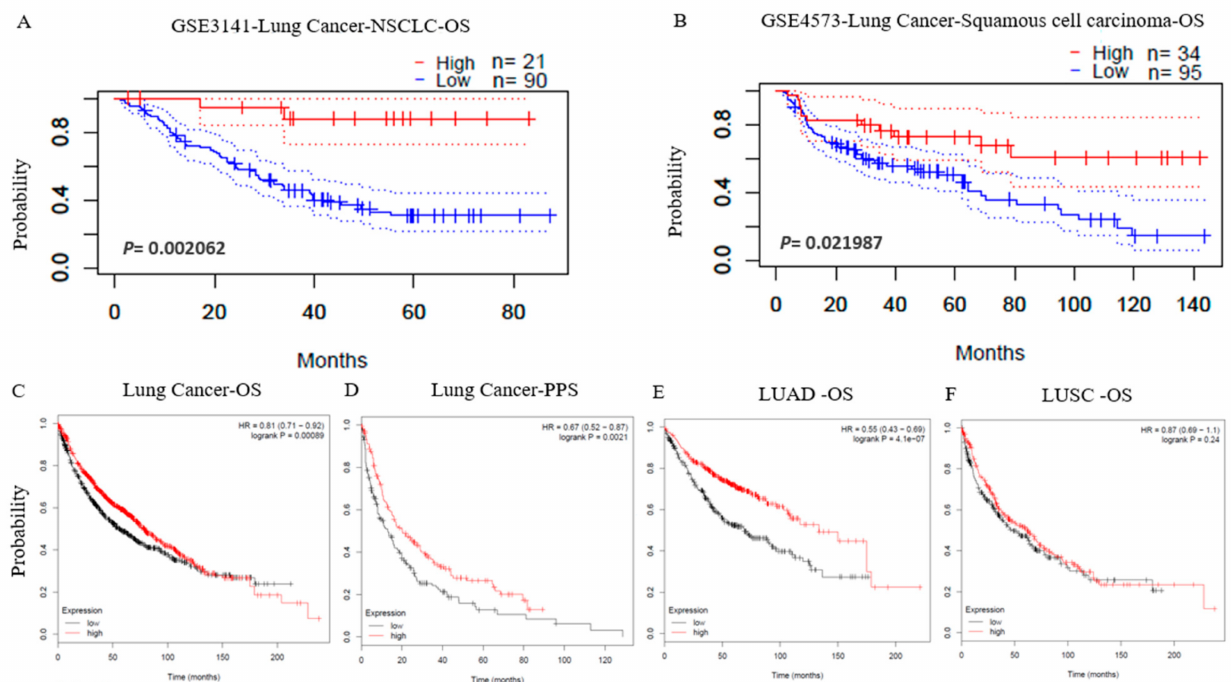
Figure 2. Kaplan–Meier survival curves comparing the high and low expression of LPAR6 in different types of cancer in the PrognoScan and Kaplan–Meier plotter databases. ( A , B ) Survival curves of OS in two lung cancer cohorts [GSE3141 ( n = 111, p = 0.00206181) and GSE4573 ( n = 129, p = 0.0219869)] and DSS in bladder cancer cohort [GSE13507 ( n = 165, p = 0.0067285)]. ( C , D ) Survival curves of OS ( n = 1926) and PPS ( n = 344) of the lung cancer. ( E , F ) Survival curves of OS of the lung adenocarcinoma ( n = 720) and squamous cell carcinoma ( n =